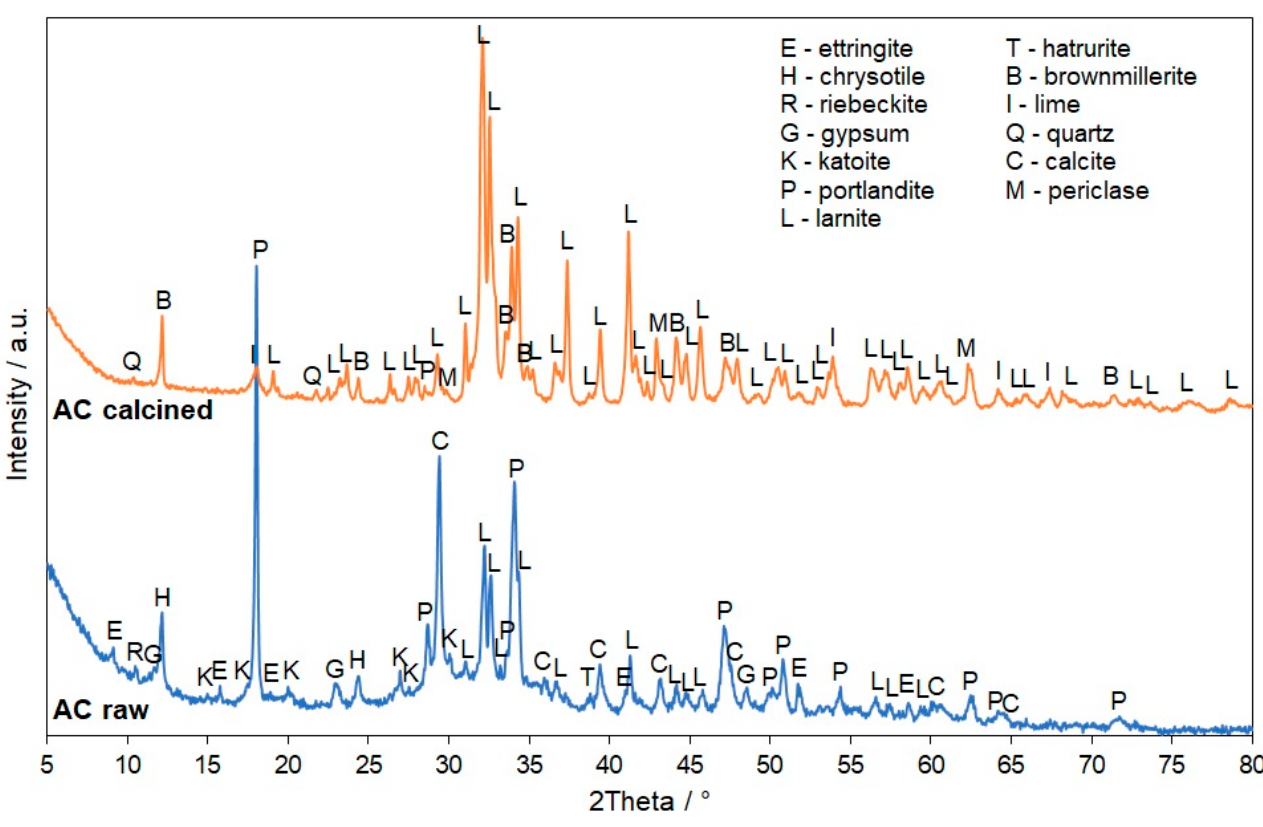
Figure 3. XRD patterns of AC sample, raw and after calcination.